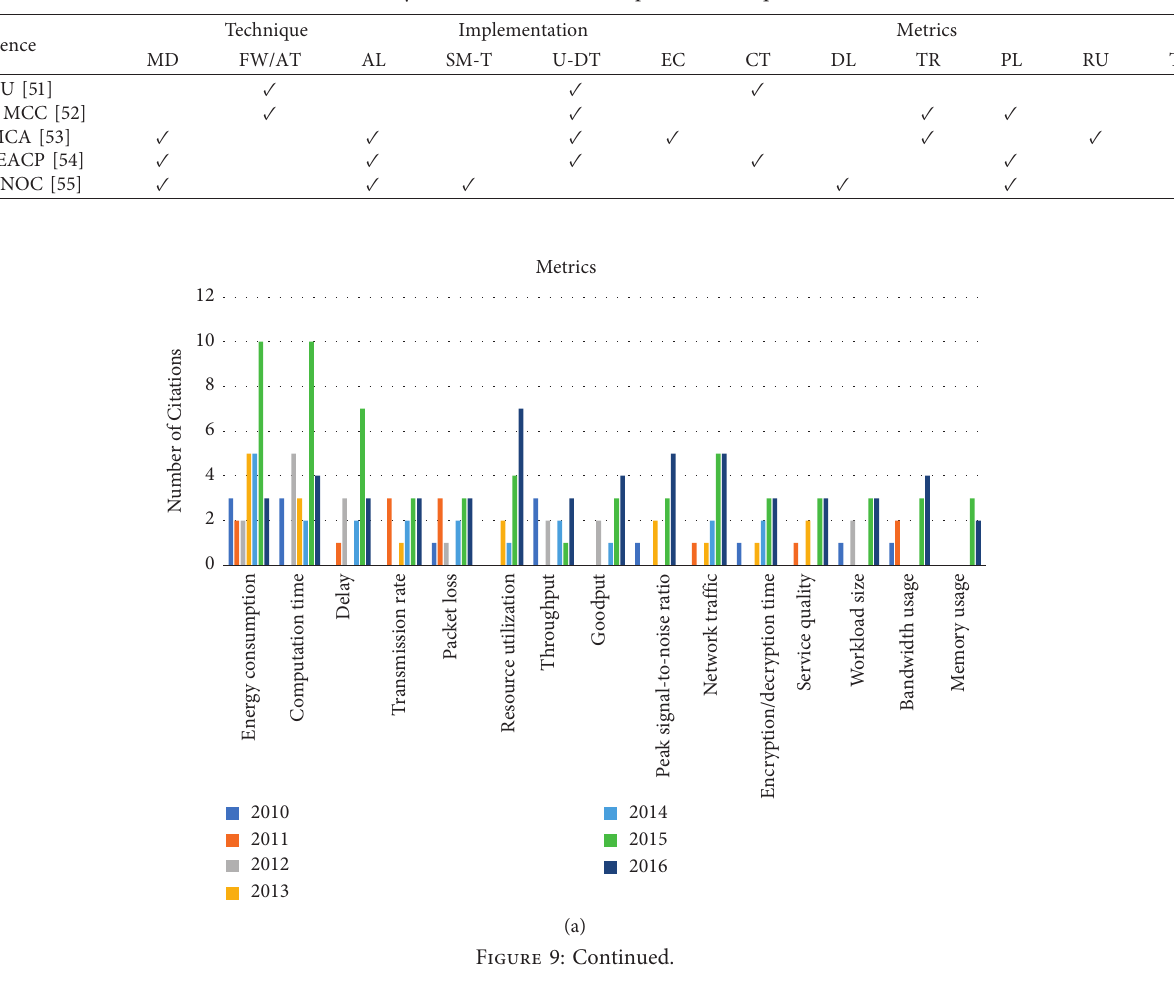
Table 10: Analysis of QoS-aware development techniques in MCC.